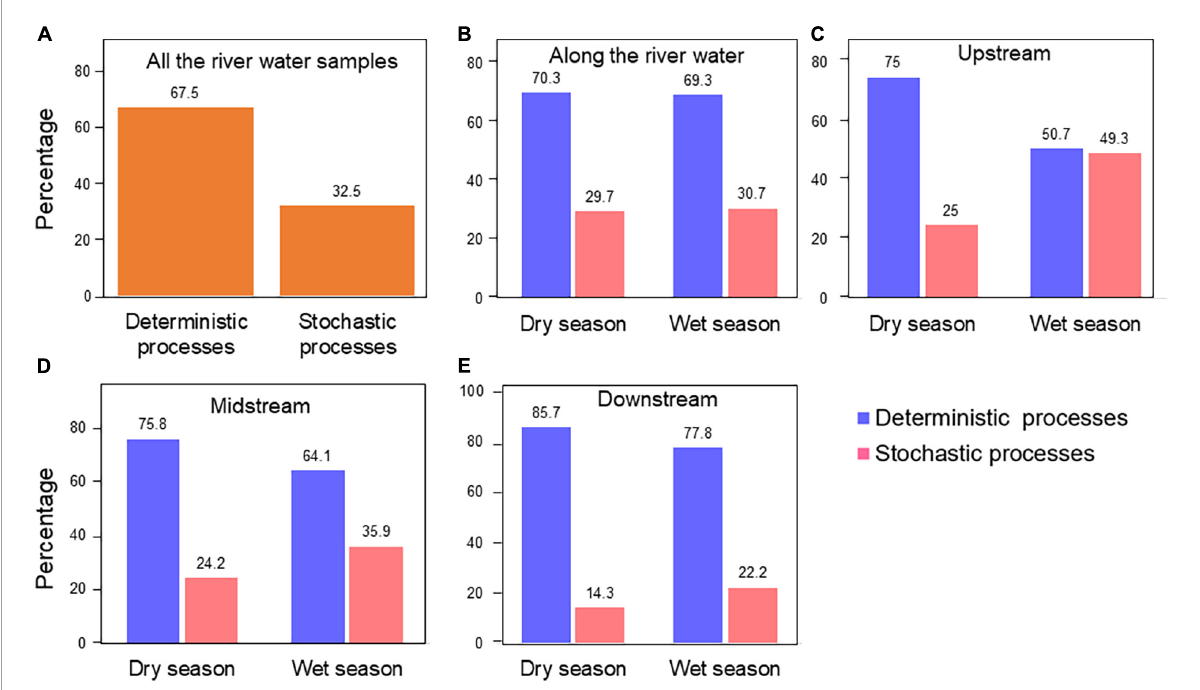
FIGURE3 The summary contribution of ecological processes that govern the assembly of the microbial communities of all the Chishui River samples (A) , at the whole Chishui River scale (B) , upstream (C) , midstream (D) , and downstream (E) . The percentages (numbers on the individual bars) are given the relative contribution of the deterministic and stochastic processes to the community succession at different river sections.